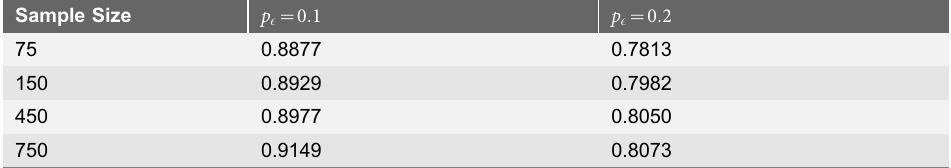
Table 3. Correct prediction rate of BIBN under difference